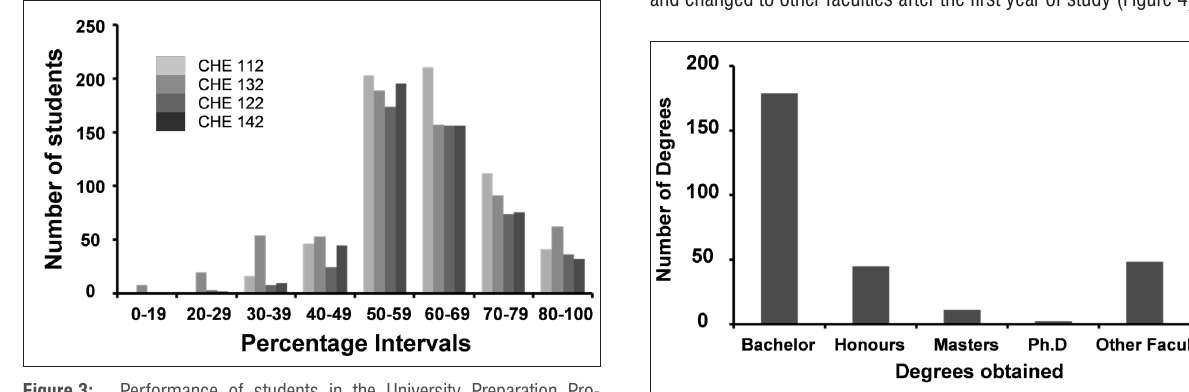
Figure 3: Performance of students in the University Preparation Pro- gramme in the first-year Chemistry modules (CHE112, CHE132, CHE122 and CHE142 over the period 2010-2014). The skewness to the right is an indication of a high pass rate.